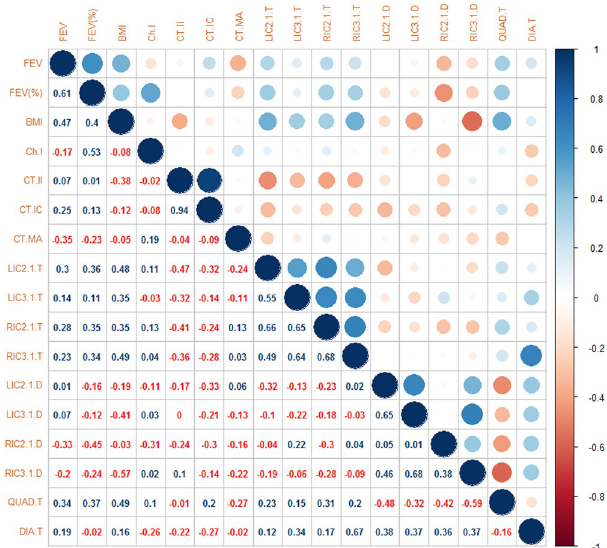
Figure 5. Correlation matrix. BMI – body mass index Ch.I – Charlson comorbidity index CT.II – CT intercostal index CT.IC – Total CT intercostal muscle area CT.MA – CT intercostal muscle mean attenuation LIC2.1.T – 2 nd left intercostal thickness LIC3.1.T – 3 rd left intercostal thickness. RIC2.1.T – 2 nd right intercostal thickness RIC3.1.T – 3 rd right intercostal thickness. LIC2.1.D – 2 nd left intercostal density LIC3.1.D – 3 rd left intercostal density RIC2.1.D – 2 nd right intercostal density RIC3.1.D – 3 rd right intercostal density Quad.T – rectus femoris thickness Dia.T – diaphragm